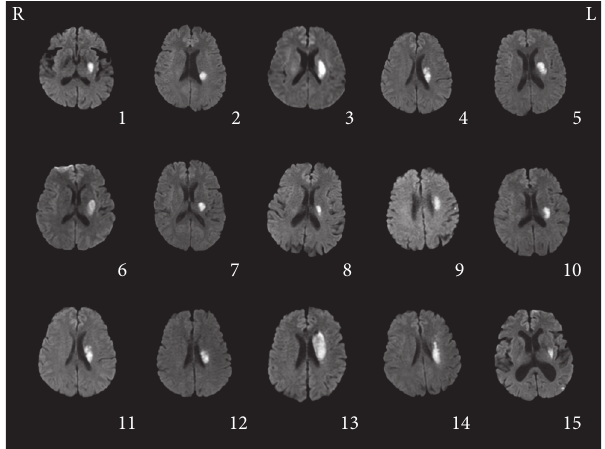
Figure 1: Individual diffusion weighted images in the axial view. The panel shows the slice with maximum infarct volume. Each subject is coded by the same serial number as the first row in Table